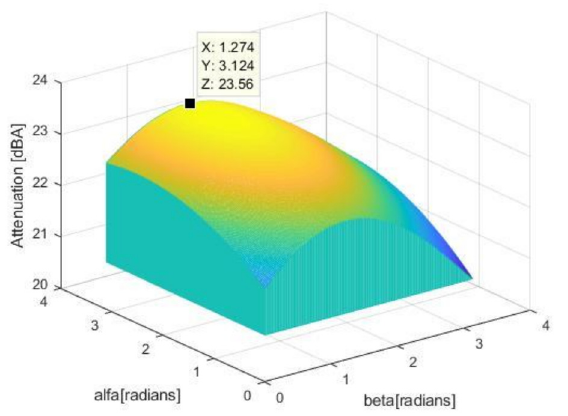
Figure 11. Sound attenuation: Distance barrier-receiver 35 m; sound frequency = 4000 Hz; relative humidity 20%; σ e = 104 kPa · s · m − 2